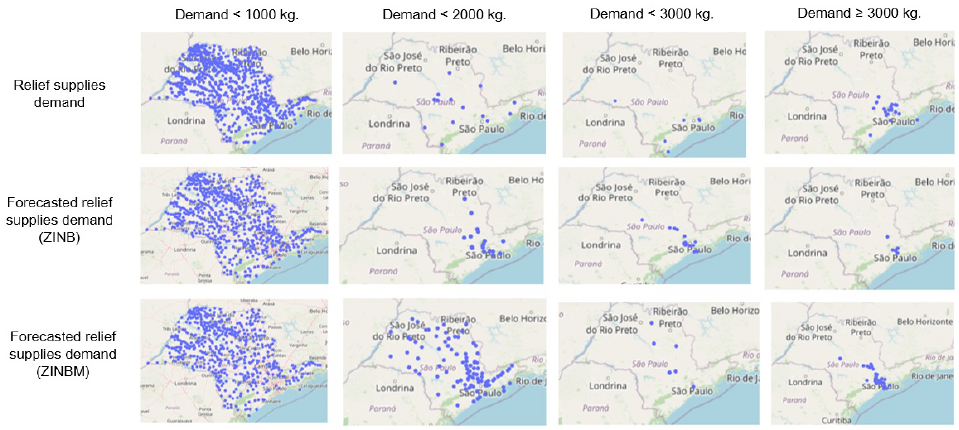
Figure 5. Geographic view of actual demand vs. estimated